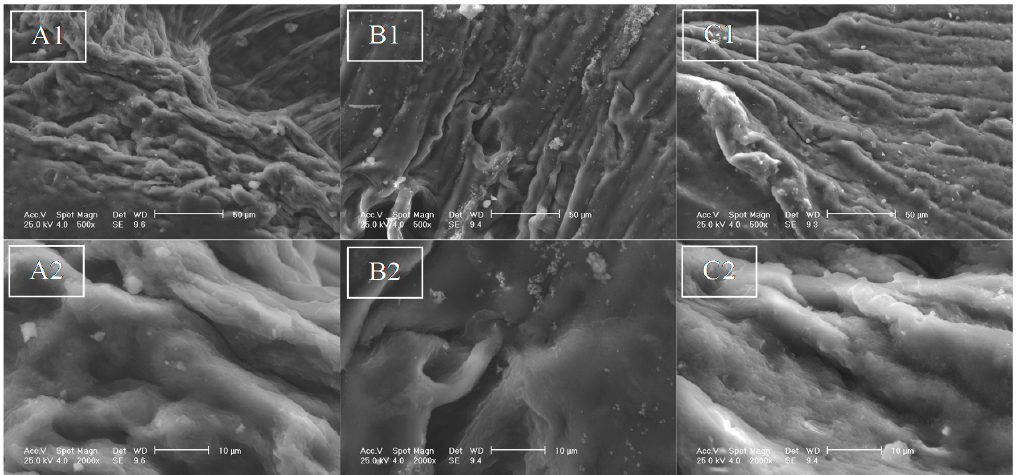
Figure 6. SEM images of GG ( A ), GG with sorbed Zn (II) ( B ) and GG/GO with sorbed Zn (II) ( C ). Index 1 is for 500× magnification and index 2 for 2000× magnification.